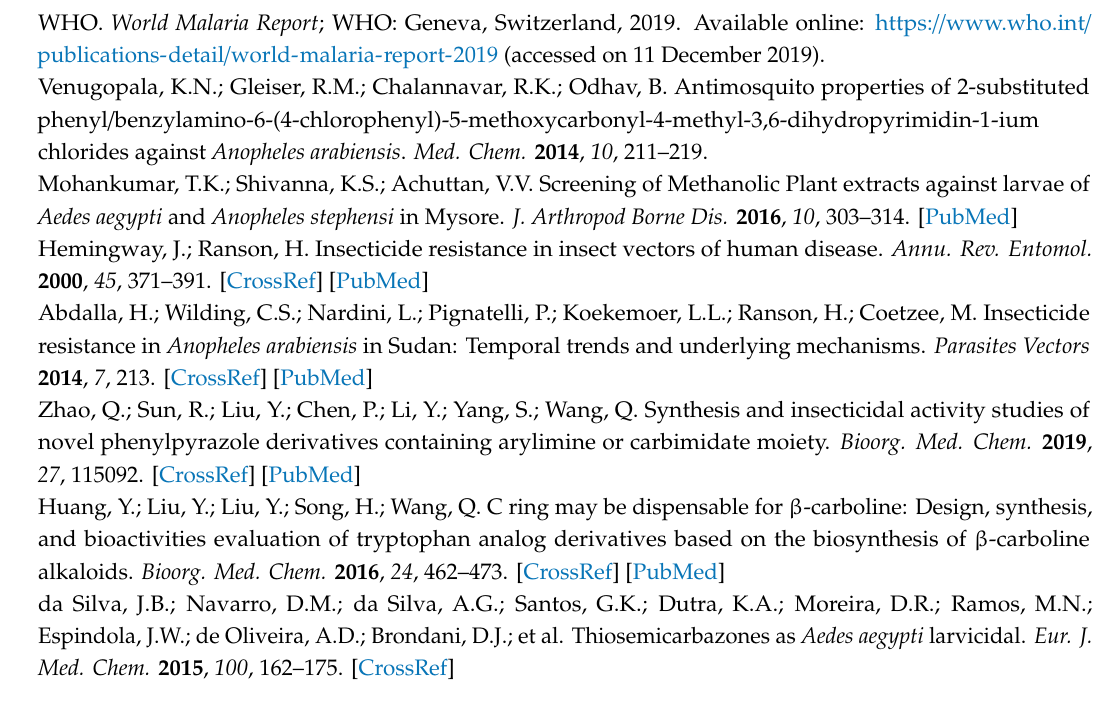
(3 j ); Figure S29: 1 H-NMR of 2-(4- fluorophenyl)-2,3- dihydroquinazolin- 4(1 H )-one (3 j ); Figure S30: 13 C-NMR of 2-(4- fluorophenyl)-2,3- dihydroquinazolin- 4(1 H )-one (3 j ); Figure S31: FT-IR of 2-(1H-imidazol- 4-yl)-2,3- dihydroquinazolin- 4(1 H )-one (3 k ); Figure S32: 1 H-NMR of 2-(1H- imidazol-4-yl)-2,3- dihydroquinazolin- 4(1 H )-one (3 k ); Figure S33: 13 C-NMR of 2-(1H- imidazol-4-yl)-2,3- dihydroquinazolin- 4(1 H )-one (3 k ); Figure S34: FT-IR of 2-(2-methoxy-4-nitrophenyl)-2,3- dihydroquinazolin- 4(1 H )-one (3 l ); Figure S35: 1 H-NMR of 2-(2-methoxy-4-nitrophenyl)-2,3- dihydroquinazolin- 4(1 H )-one (3 l ); Figure S36: 13 C-NMR of 2-(2-methoxy-4-nitrophenyl)-2,3- dihydroquinazolin- 4(1 H )-one (3 l ); Figure S37: FT-IR of 2-(2-hydroxy- 5- nitrophenyl)-2,3- dihydroquinazolin- 4(1 H )-one (3 m ); Figure S38: 1 H-NMR of 2-(2-hydroxy- 5- nitrophenyl)-2,3- dihydroquinazolin- 4(1 H )-one (3 m ); Figure S39: 13 C-NMR of 2-(2-hydroxy- 5- nitrophenyl)-2,3- dihydroquinazolin- 4(1 H )-one (3 m ); Figure S40: FT-IR of 2-(4- hydroxyphenyl)-2,3- dihydroquinazolin- 4(1 H )-one (3 n ); Figure S41: 1 H-NMR of 2-(4-hydroxyphenyl)-2,3-dihydroquinazolin- 4(1 H )-one (3 n ); Figure S42: 13 C-NMR of 2-(4-hydroxyphenyl)-2,3-dihydroquinazolin- 4(1 H )-one (3 n